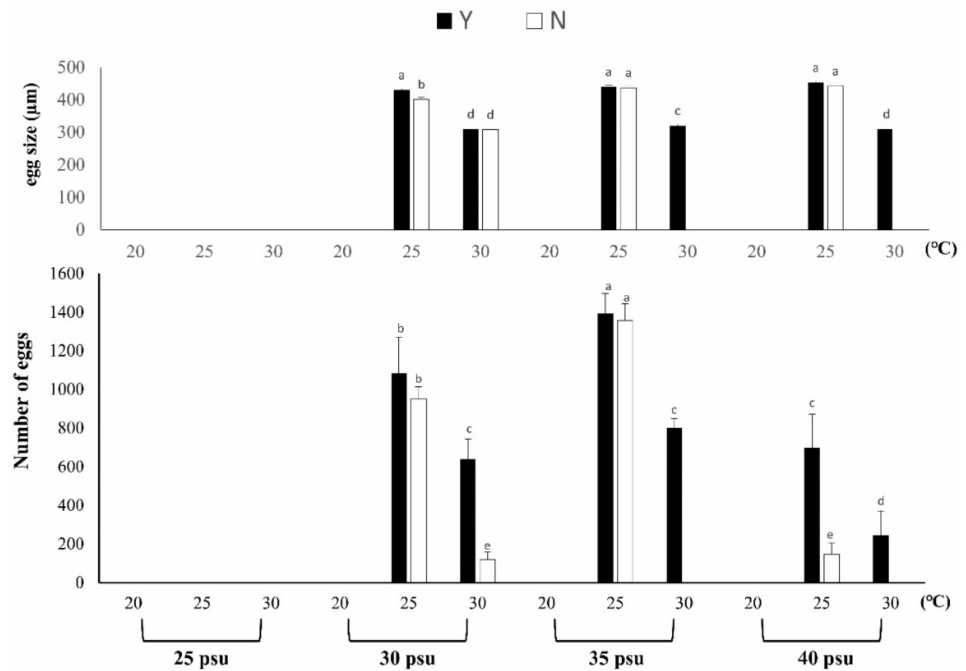
Figure 5. The effect of feeding on Briareum violacea egg size and number of eggs under temperature and salinity stress. Different Latin alphabet letters indicate significant differences among groups ( p < 0.05). The values are expressed as the means ± SDs ( n = 30 colonies). Y: feeding treatment group, N: nonfeeding treatment